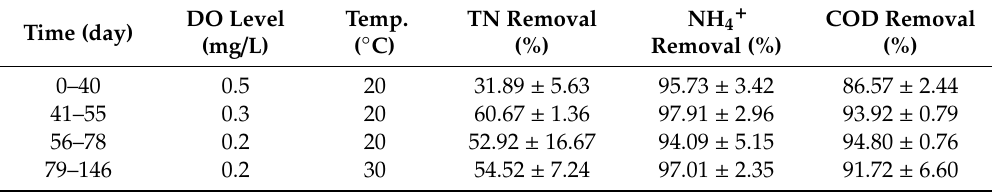
Table 2. Summary of reactor performance as a function of DO and